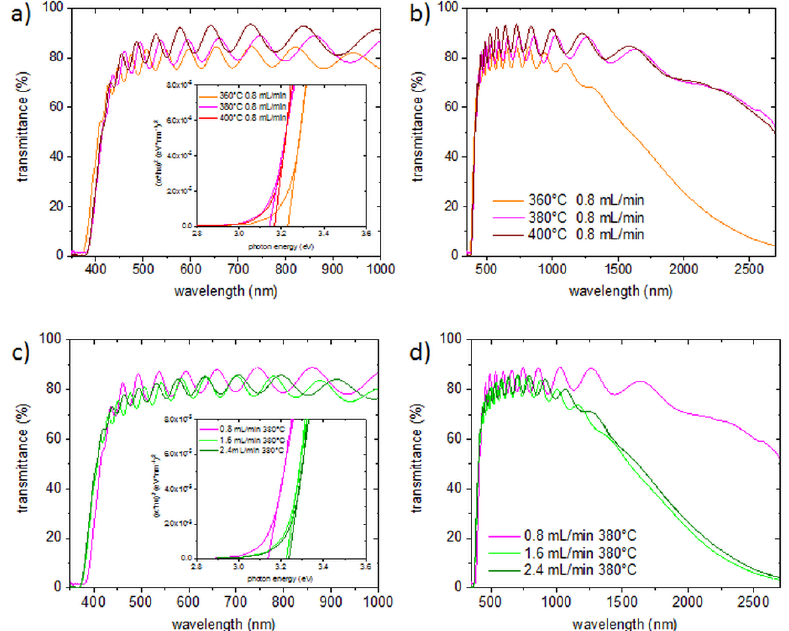
Figure 5. FTIR spectra for ( a,b ) variations in the deposition temperature and ( c,d ) variations in the solution flow rate. Insets in ( a , c ) show the Tauc plots for extraction of the optical band gap.